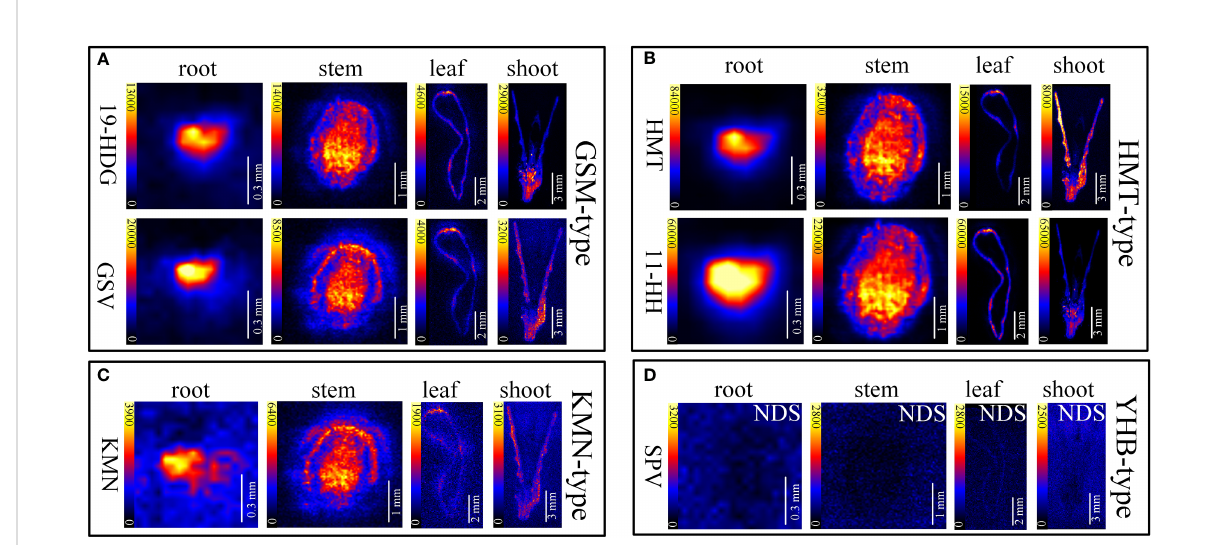
FIGURE 3 In situ visualization of alkaloids in sections of mature roots, stems, leaves and shoots. The color scale from dark to yellow indicates the regions of minimum (absence) and maximum relative quanti fi cation of multiple alkaloids in different organ/tissue. The relative quanti fi cations of alkaloids were performed according to the image brightness intensities captured by the DESI-MSI. The names of the alkaloids are abbreviated. (A) Gelsmine-type (GSM-type) alkaloids. 19-HDG, 19-( R )-hydroxydihydrogelsemine ( m/z 341.1865); GSV, gelsevirine ( m/z 353.1865). (B) Humantenine-type (HMT-type) alkaloids. HMT, humantenine ( m/z 355.2022); 11-HH, 11-hydroxyhumantenine ( m/z 371.1971). (C) Koumine-type (KMN-type) alkaloids. KMN, kouminol ( m/z 325.1916). (D) Yohimbane-type (YHB-type) alkaloids; SPV, sempervirine ( m/z 273.1370). NDS means no detectable signal. Each organs/tissues had three replicates and analyzed by DESI-MSI.